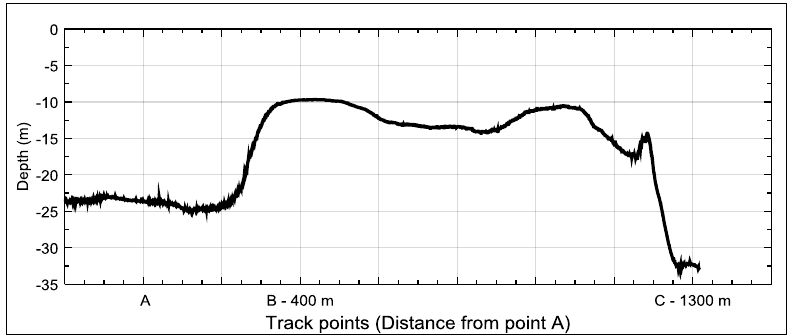
Figure 5. Bottom depth profile of the surveyed path. The average bottom depth was 24 m for zone-A, 12 m for zone-B and 33 m for zone-C. The total survey path was 1300 m long.